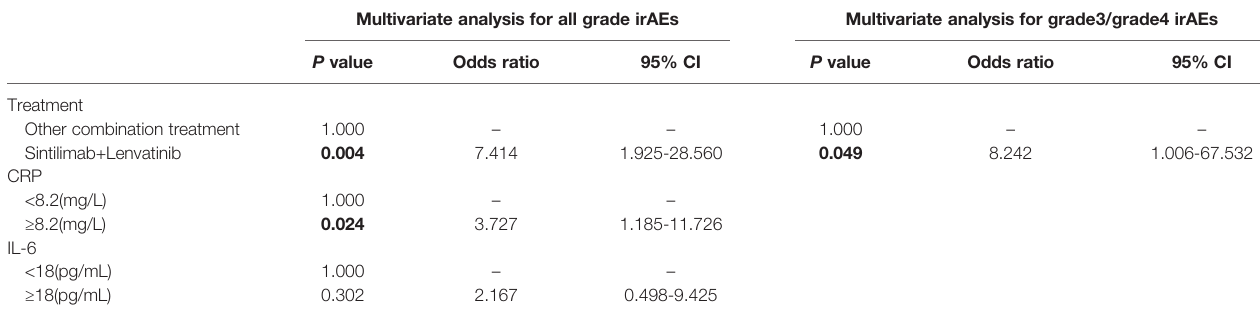
TABLE 3 | Multivariate binary logistic regression analysis for risk factors of all grade and grade3/grade4 irAEs. Multivariate analysis for all grade irAEs Multivariate analysis for grade3/grade4